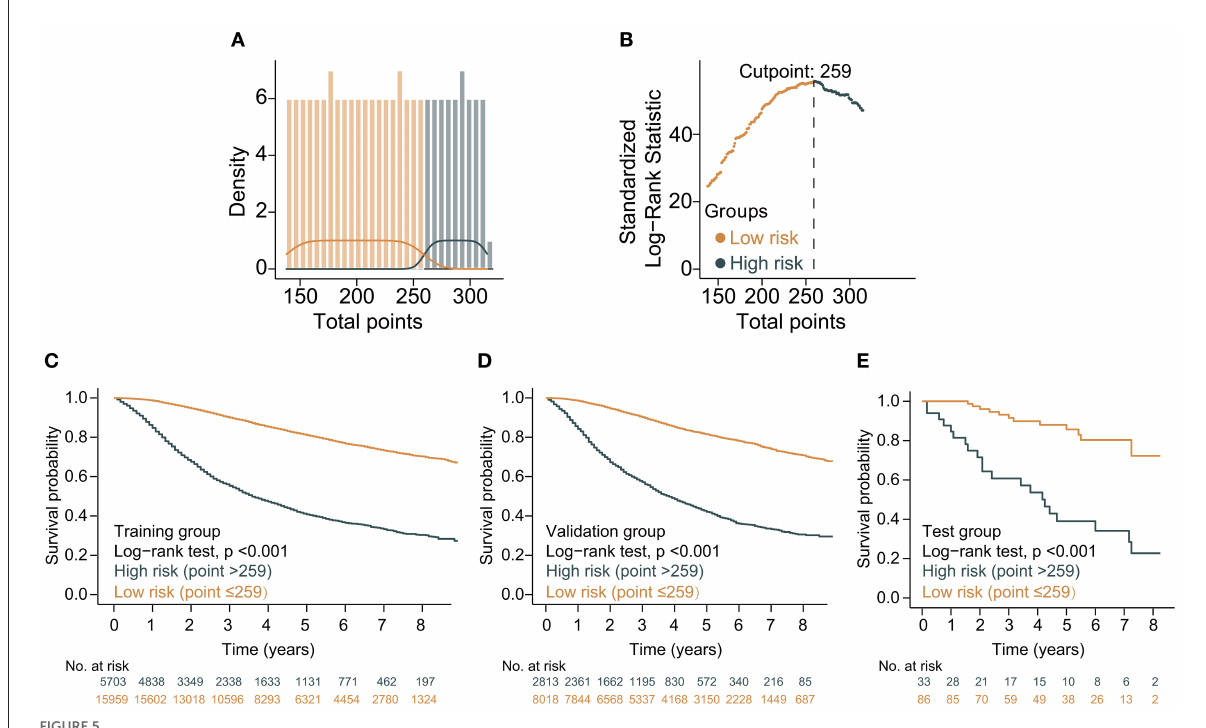
FIGURE5 Construction and validation of risk stratification based on the total points of the condition survival nomogram. (A) Distribution of total risk points; (B) The standardized log-rank statistics; (C–E) Kaplan–Meier for estimating risk stratification in training, validation, and testing groups,